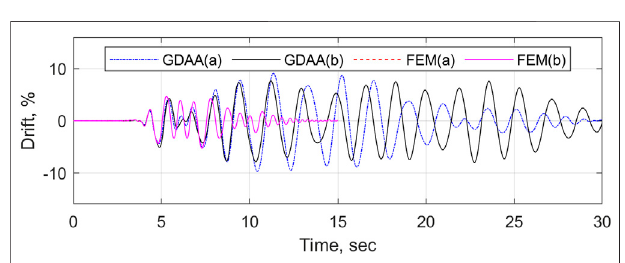
FIGURE 11 | Lateral drift time histories of the FEM and the GDAA for (a) the horizontal component of Sylmar alone; and (b) the horizontal and vertical components of Sylmar